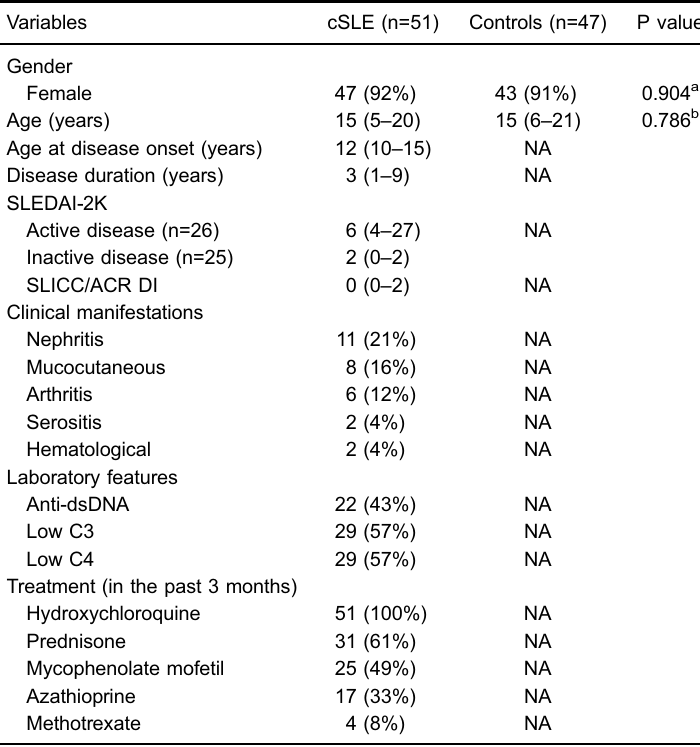
Table 1. Demographics and clinical, laboratory, and treatment features of childhood-onset systemic lupus erythematosus (cSLE) patients and controls included in the